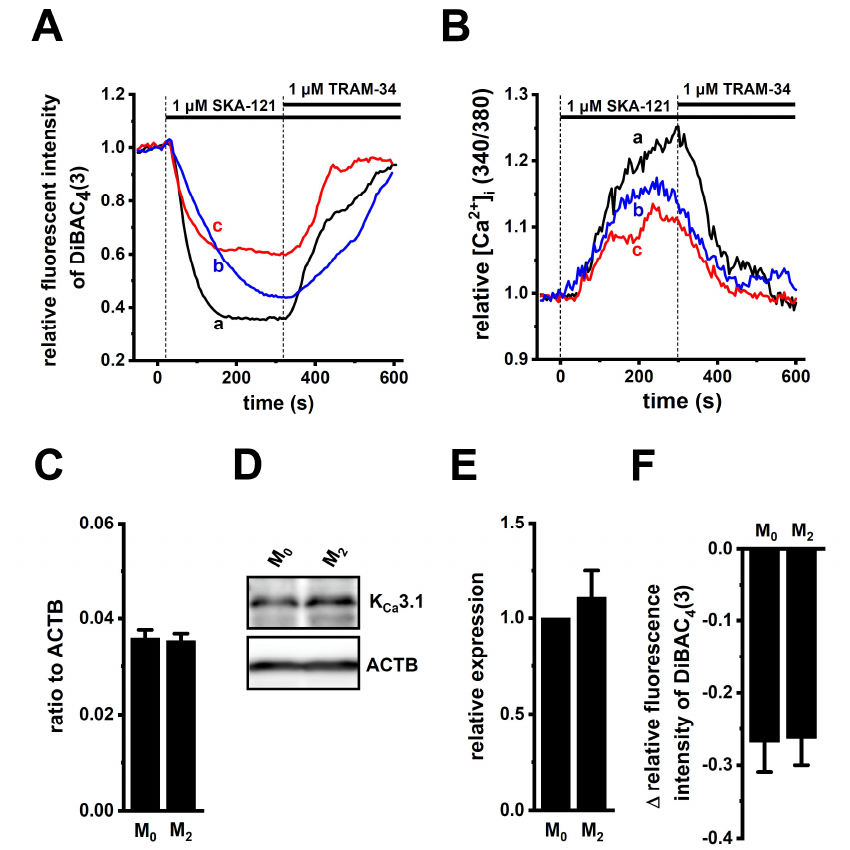
Figure 2. Functional expression of K Ca 3.1 in THP-1-derived M 2 macrophages. ( A , B ): Simultaneous measurements of changes in the membrane potential ( A ) and [Ca 2+ ] i ( B ) in the three different cells [a (black), b (blue), and c (red)], following the application of a selective K Ca 3.1 activator, SKA-121 (1 µ M), and/or the K Ca 3.1 inhibitor, TRAM-34 (1 µ M) using DiBAC 4 (3) and Fura 2, respectively. The relative time-course changes in fluorescence intensities (1.0 at 0 s) from three different THP-1-derived M 2 macrophages are shown. ( C ): Real-time PCR examination of K Ca 3.1 expression in THP-1-derived M 0 macrophages (‘M 0 ’) and M 2 macrophages (‘M 2 ’). Expression levels are shown as a ratio to ACTB ( p > 0.05, n = 4 for each). ( D , E ): Protein expression levels of K Ca 3.1 in the ‘M 0 ’ and ‘M 2 ’ groups were determined by Western blot. Specific band signals for K Ca 3.1 were observed at approximately 50 kDa ( D , upper panel). After compensation with the optical density of the ACTB signal (43 kDa) ( D , lower panel), the expression level in the ‘M 0 ’ group was expressed as 1.0 ( p > 0.05, n = 4 for each) ( E ). ( F ): SKA-121 (1 µ M)-induced relative hyperpolarizing responses in the ‘M 0 ’ and ‘M 2 ’ groups ( p > 0.05, n = 37 and 29, respectively).